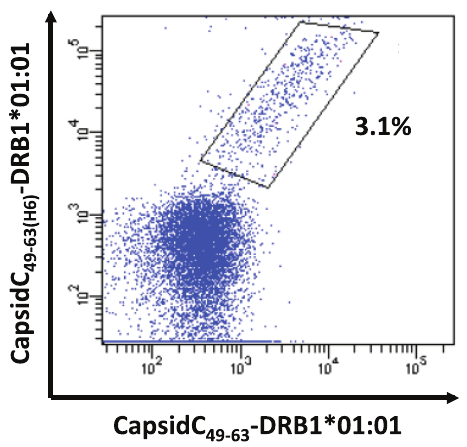
Figure 6. Head to head comparison of MHC class II tetramers generated with H 6 -tagged peptides versus non-H 6 -tagged peptides. PBMCs in vitro cultured with a yellow fever epitope were stained with two tetramers carrying the same peptide-HLA class II specificity (Yellow fever virus CapsidC 49–63 restricted to HLA- DRB1*01:01). Monomeric peptide-HLA class II complexes generated with H 6 -tagged peptide were tetramerized with PE-conjugated SA (y- axis). Monomeric peptide-HLA class II complexes generated with non- H 6 -tagged peptide were tetramerized with APC-conjugated SA (x-axis). All CD4 + T cells stained with non-H 6 -tagged tetramer are also stained with the H 6 -tagged tetramer.